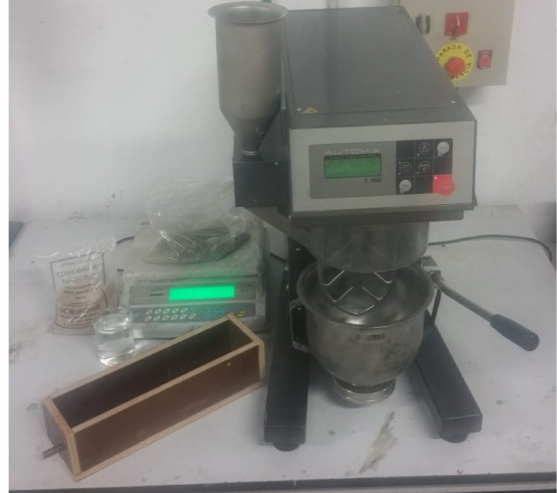
Figure 1. Photo of the wooden mold with the steel bar, the mortar mixer, and the materials used: cement